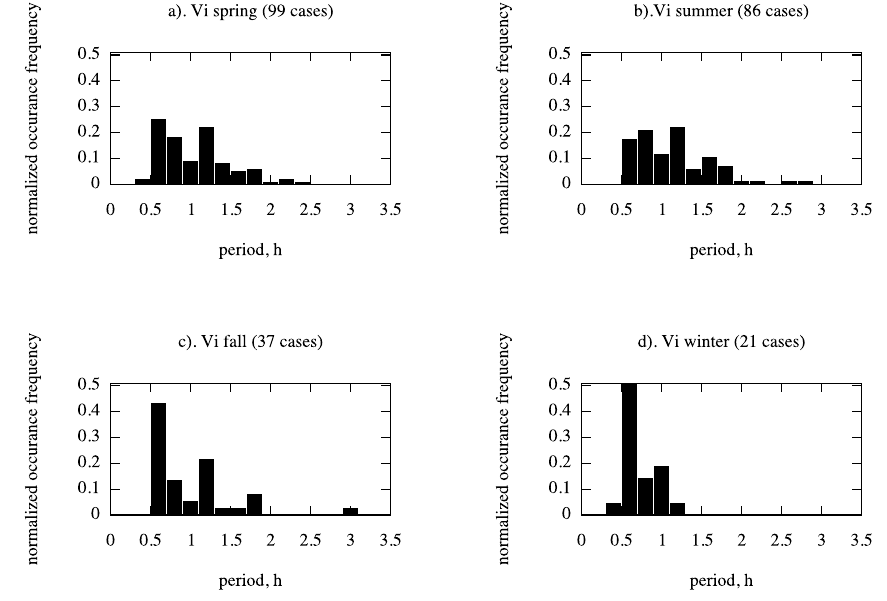
Fig. 12. Seasonal dependencies in the histograms of AGW-TID periods as observed in the ion velocity